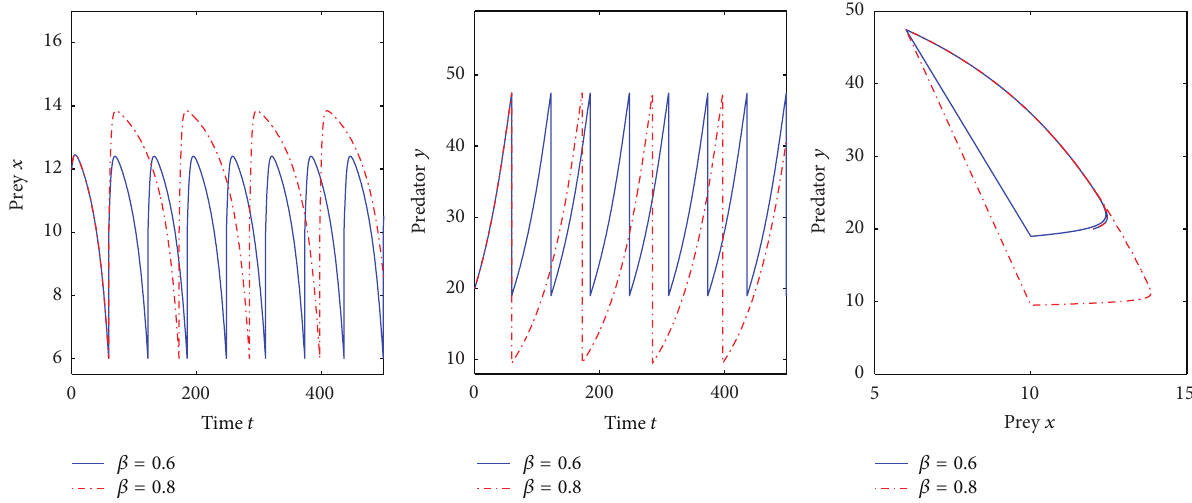
Figure 8: The time series and the portrait phase of the system (2) when 𝑟 = 0.5 , 𝐾 = 15 , 𝑎 = 100 , 𝜇 = 0.5 , 𝐷 = 0.01 , ℎ = 6 , 𝜏 = 4 , and (𝑥(0),𝑦(0)) = (12, 20) .